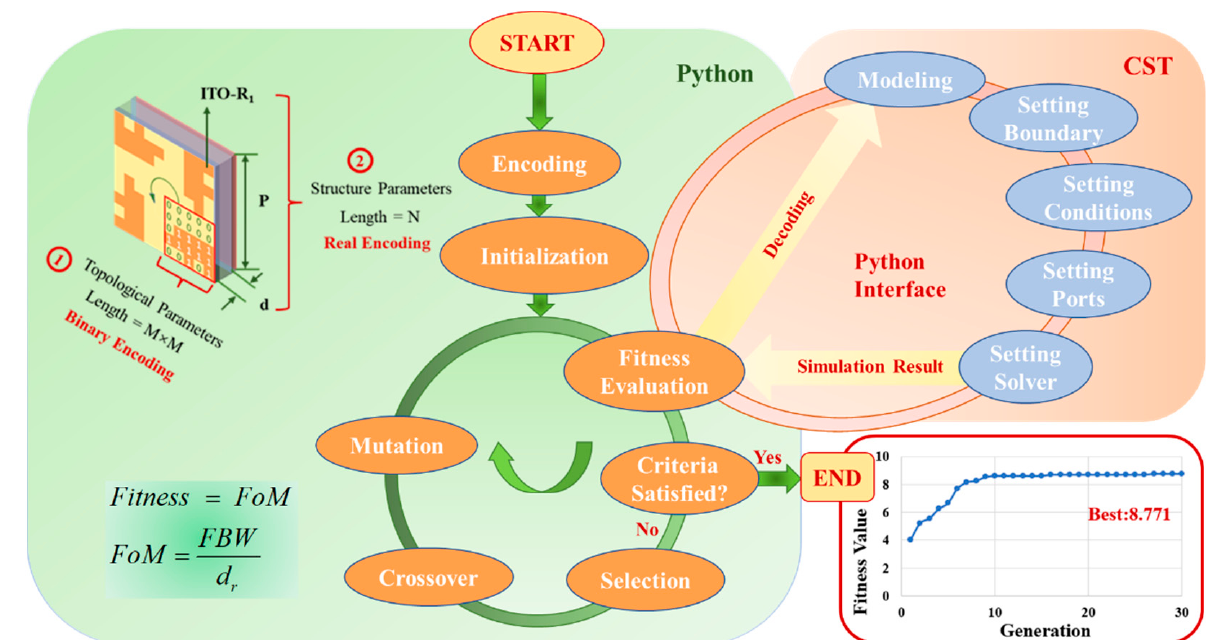
Figure 1. The schematic diagram of FTBMA design process by topology optimization combined with GA and the co-simulation.